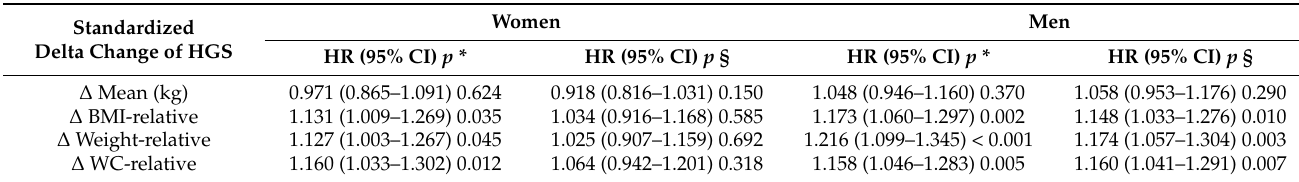
Table 4. Adjusted hazard ratio (HR) of incident metabolic syndrome associated with invers one standard deviation increase in mean hand grip strength delta change and relative muscle strength according to gender.